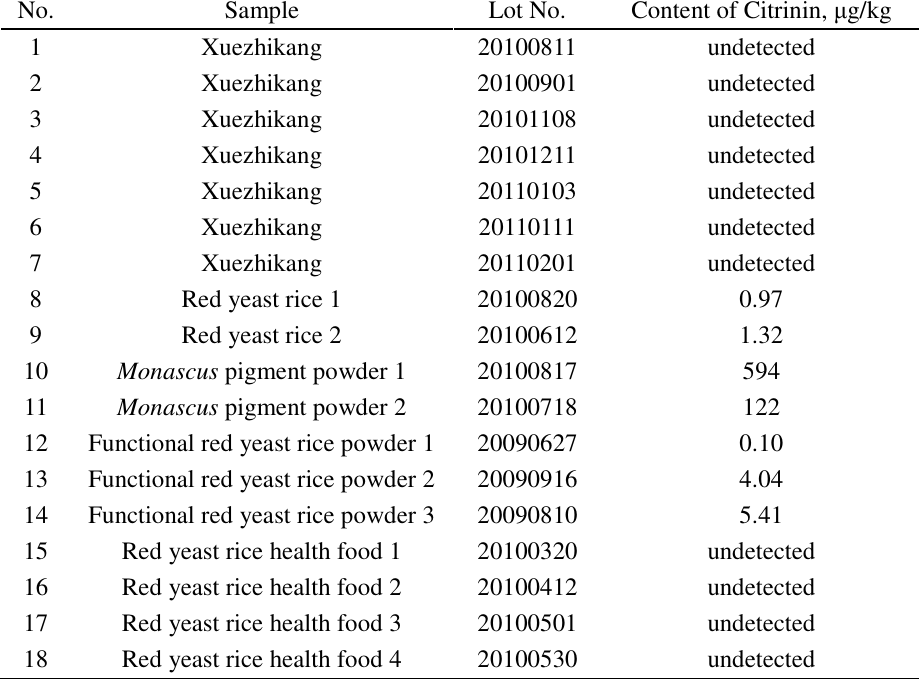
Table 5. Detection results of citrinin in 18 samples